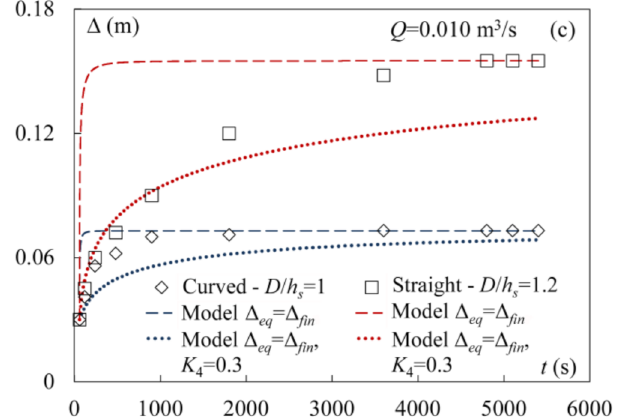
Figure 8. Comparison of numerical solutions of Equation (5) with experimental data pertaining to: ( a ) rock, grade-control structures (data not included in Pagliara and Palermo [7]); ( b ) stepped gabion weirs (data from Palermo and Pagliara [27]); ( c ) straight and curved rock sills (data from Palermo and Pagliara [27]). Numerical solutions were obtained assuming ∆ ∆ ∆ ∆ ∆ ∆ eq = eq = eq = fin (dashed line), eq,calc (continuous line), and fin and K 4 = 0.3 (dotted line).